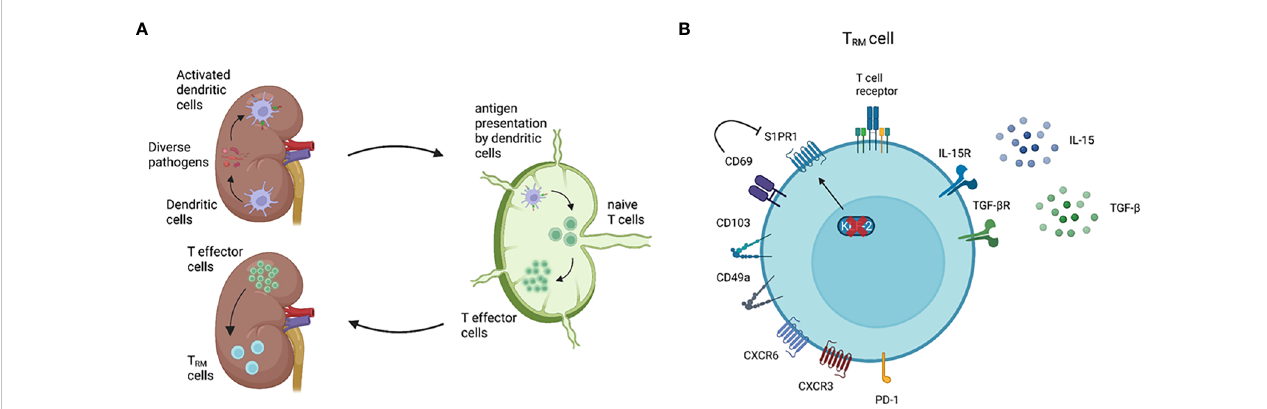
FIGURE 1 General features of T RM cells. Renal T RM cell development and phenotype. (A) As classical antigen-presenting cells (APC), dendritic cells (DCs) constantly surveil their microenvironment for pathogens and microbes. Once DCs in the kidney are activated, these cells migrate to the renal draining lymph nodes to present the processed antigen via the major histocompatibility complex (MHC) to naïve T cells (3). Upon activation, naïve T cells become effector T cells and migrate to the in fl amed kidney via a chemokine gradient (4). While most of the effector T cells undergo apoptosis following the resolution of in fl ammation, a small subset of the effector T cells become T RM cells. T RM cells are the most abundant immune cell population in the healthy human kidney (5). (B) A T RM cell marker CD69 downregulates the expression of S1PR1, which is a receptor required for tissue egress. The expression of transcription factor KLF-2, which upregulates S1PR1 expression, is downregulated in T RM cells (6). CD103 and CD49a are parts of the integrins a E b 7 and a 1 b 1, respectively. CD103 interacts with E-cadherin on epithelial cells, whereas CD49a binds to collagen IV (2, 7). Almost all renal T RM cells express the chemokine receptor CXCR3 and, to a lower degree, CXCR6 (8). Inhibitory receptors, especially PD-1, are commonly expressed on T RM cells compared with circulating memory T cells. IL-15 and TGF- b are required to induce and maintain renal T RM cells in mice (9, 10). Created with